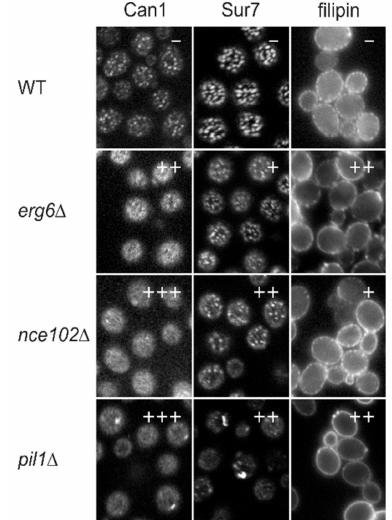
Figure 1. Distribution of membrane compartment of Can1 (MCC) markers in selected knockout strains. Distributions of Can1-GFP, Sur7-GFP, and filipin-stained sterols were monitored in the library of single gene deletion strains. Examples of detected phenotypes (classification of phenotypes: wild type [WT]—like, − ; weak, + ; medium, ++ ; strong, +++ ) on tangential confocal sections (Can1 and Sur7) or wide-field images (filipin; transversal sections) are presented. Figure adapted from [6] ( © 2008 Grossmann et al. Originally published in Journal of Cell Biology. https: // doi.org / 10.1083 /